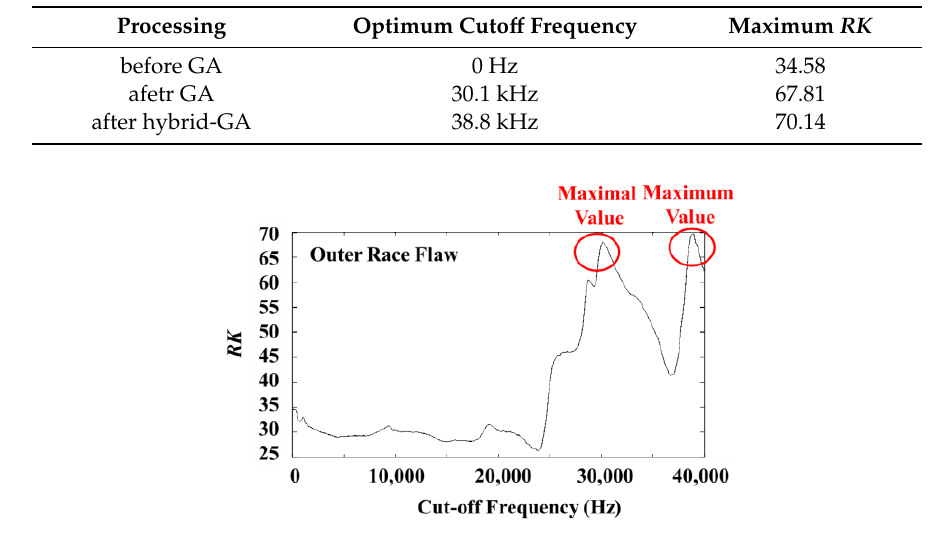
Figure 9. Change curve of cutoff frequency and RK in outer race flow data at CH1.